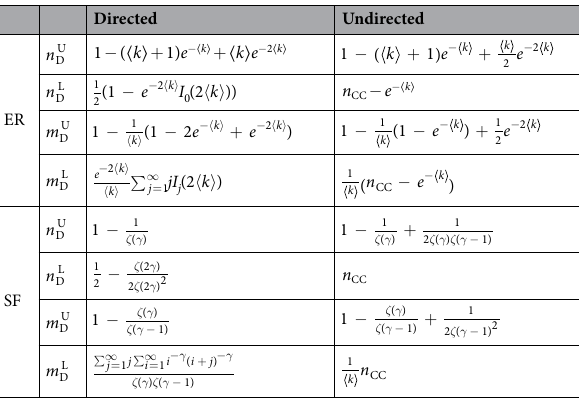
Table 2. Analytical results of controllability for upper and lower bounds. Formulas for n DU and m DU (upper bounds) and n DL and m DL (lower bounds) for directed and undirected ER and SF ( κ → ∞ ) networks. The average degree is 〈 k 〉 = 〈 k in 〉 = 〈 k out 〉 = M / N , I a ( x ) is the modified Bessel function of the first kind, ζ ( x ) is the Riemann zeta function, and n C C is the expected fraction of isolated components in the ER undirected networks. Note that the average degree is 〈 k 〉 = ζ ( γ )/ ζ ( γ − 1) for SF networks with parameter κ → ∞ (see Supplementary Note 5 for